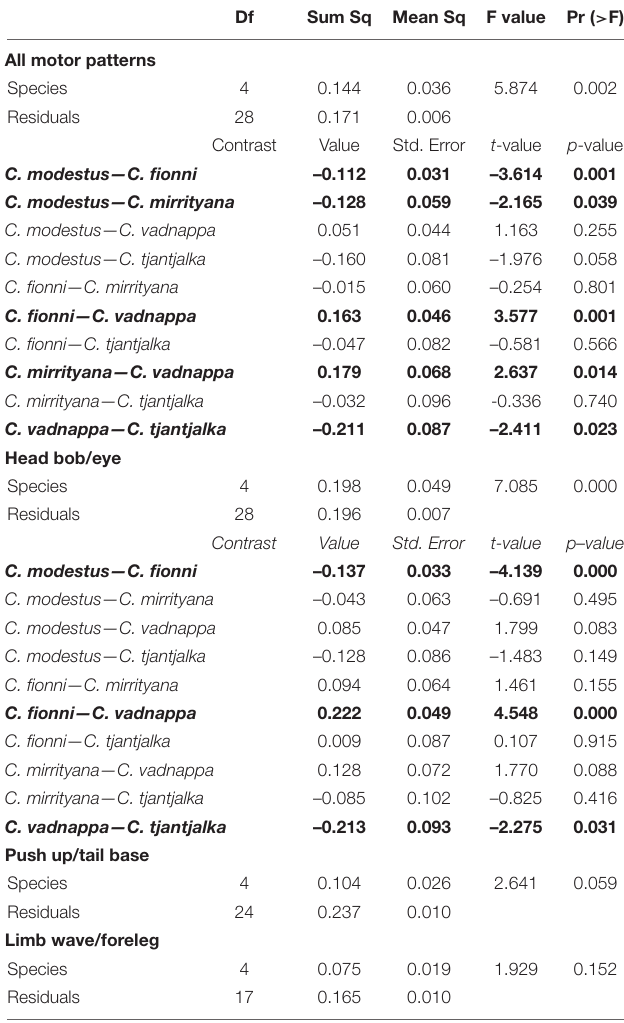
TABLE 3 | Outcome of statistical models for speed of movement, showing the results for all motor patterns combined, and for individual motor patters. Df Sum Sq Mean Sq F value Pr ( >